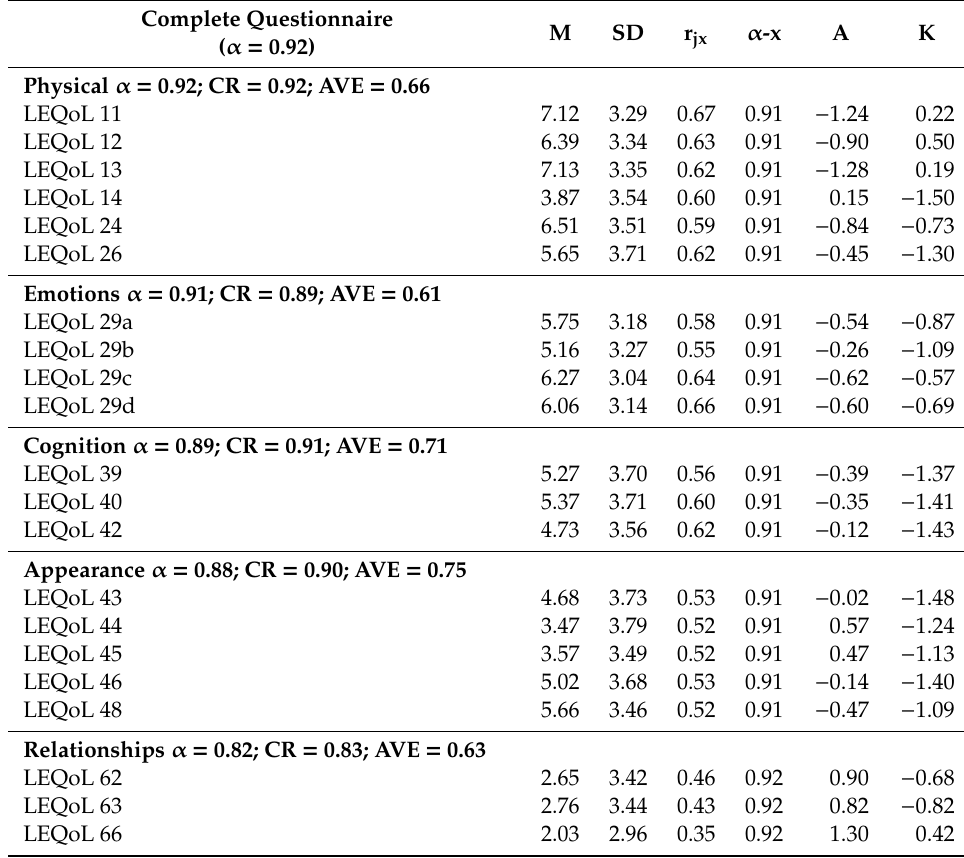
Table 2. Analysis of the 21 items of the LEQoL: mean (M), standard deviation (SD), item-total correlation (r jx ), Cronbach’s alpha if it eliminates the element ( α -x), asymmetry (A), kurtosis (K), composite reliability (CR) and average variance extracted